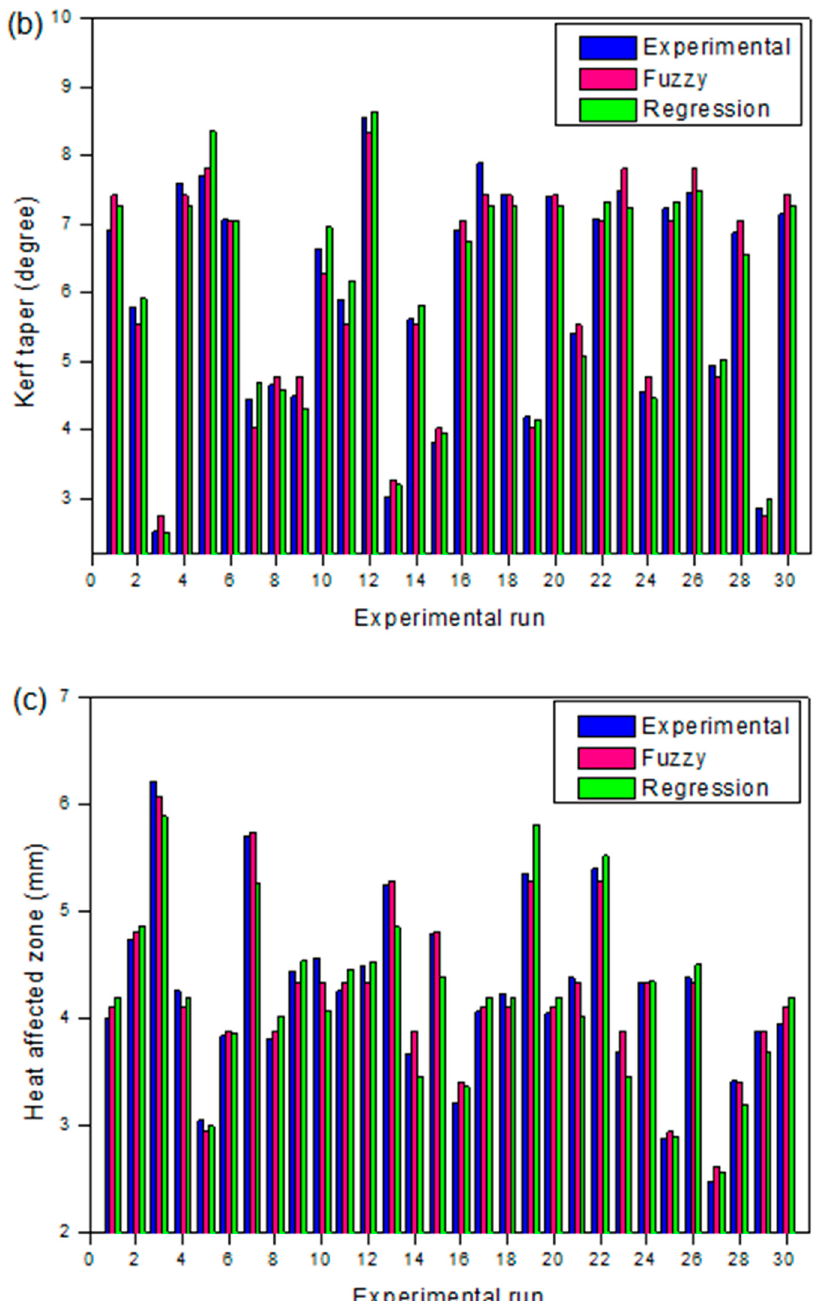
Figure 10. Correlation between fuzzy and regression predicted response values with experimental results for ( a ) MRR, ( b ) KT, and ( c ) HAZ.